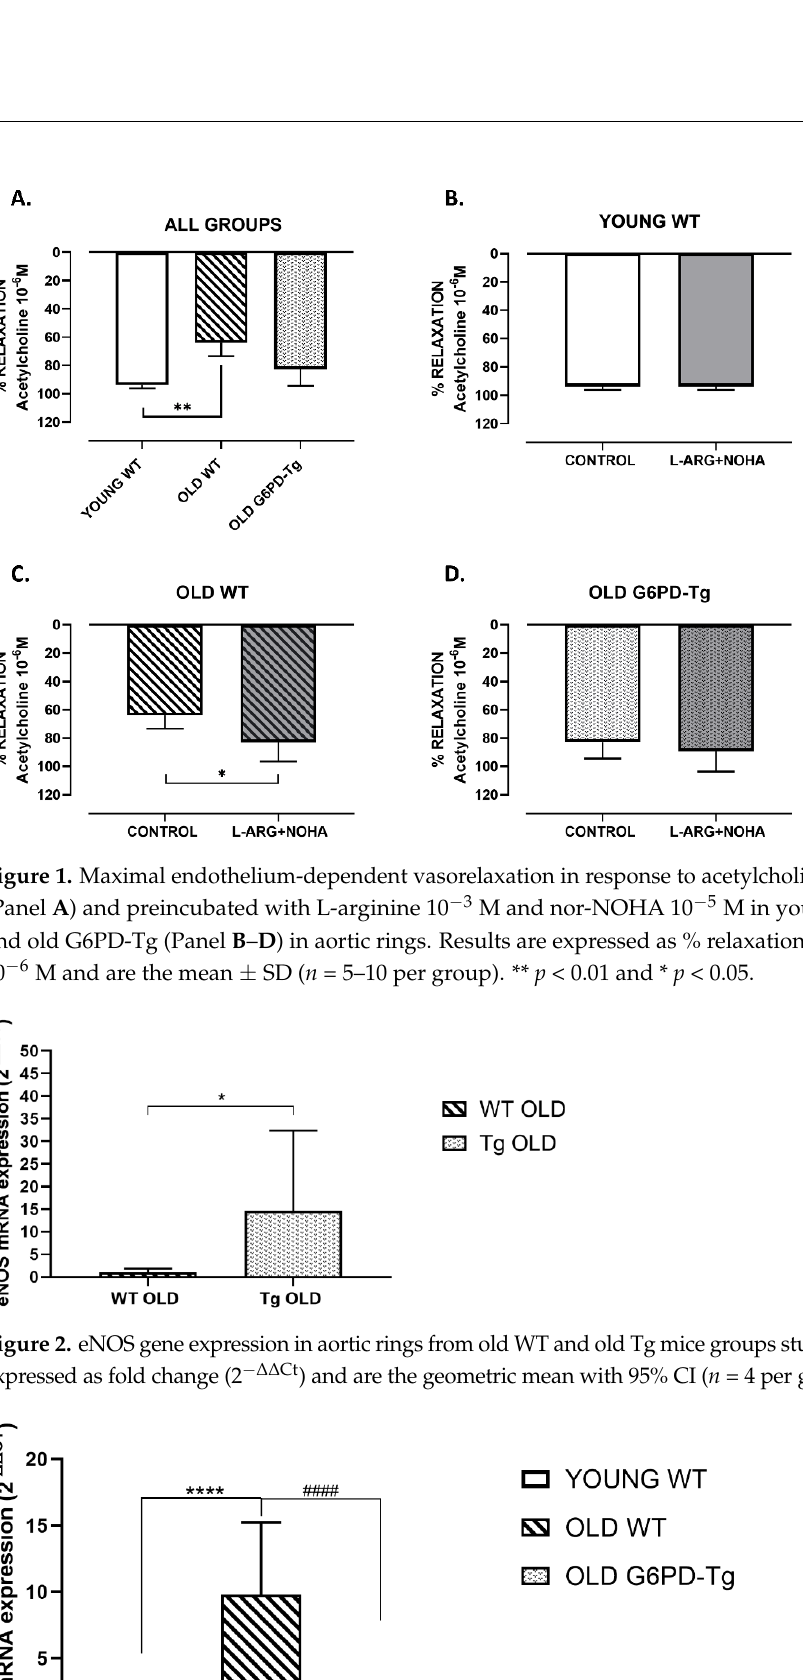
Figure 2. eNOS gene expression in aortic rings from old WT and old Tg mice groups studied. Results are expressed as fold change (2 −ΔΔ Ct ) and are the geometric mean with 95% CI ( n = 4 per group). * p < 0.05.